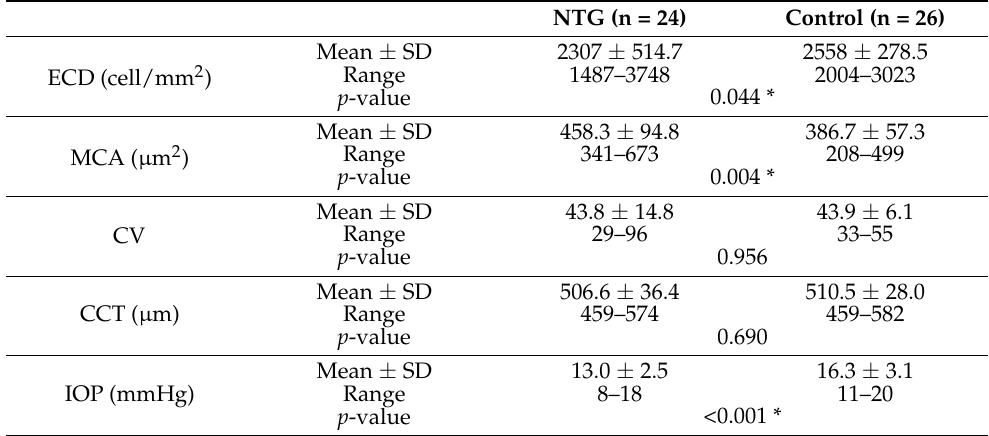
Table 2. Specular microscopy parameters and IOP of NTG patients and their matched